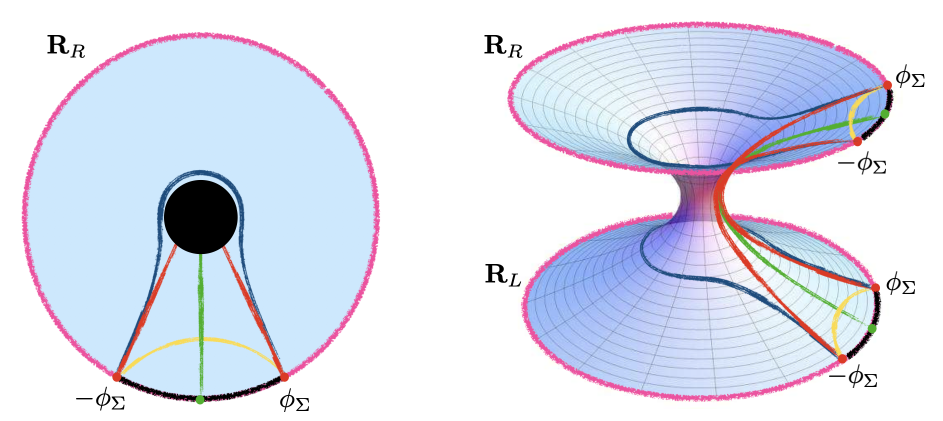
Figure 3 . Sketches of the three classes of extremal surfaces appearing in calculations of the holographic entanglement entropy for the two regions R = R = { φ : | φ | > φ in both R ∪ R L Σ asymptotic boundaries } (shown in magenta). On the left, a time slice of the right side of the eternal black hole. On the right, the same time slice but now the embedding diagram shows both sides of the Einstein-Rosen bridge. The brane corresponds to the green curve but recall that the backreaction of the brane generates extra geometry near the brane — see figure 1. In red, we have the extremal surfaces (i) contributing to the early-time phase. In blue and yellow, we have the (ii) and (iii) surfaces contributing to the thermal and island phase respectively. The latter exchange dominance depending on the size of the